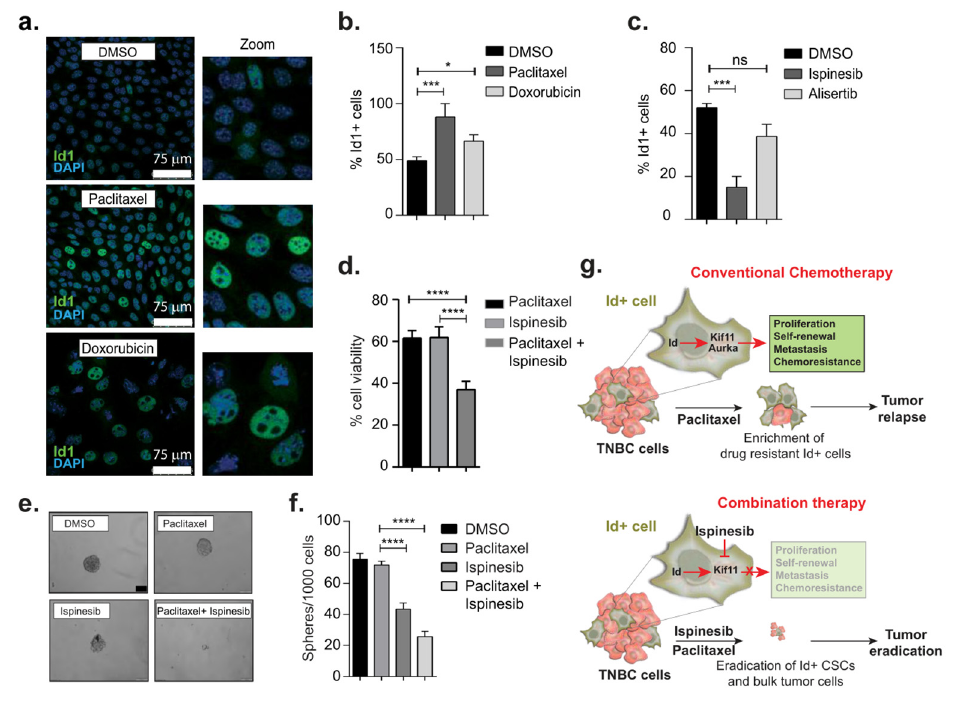
Figure 5. Therapeutic targeting of cancer stem cells (CSCs) through the Id1-Kif11 / Aurka axis. ( a ) Immunofluorescence images of cells to determine Id1 expression after treatment with paclitaxel and doxorubicin (20 × ). ( b ) Percentage cells expressing Id1 in control, paclitaxel-, and doxorubicin-treated cells as well as ispinesib and alisertib ( c ) were determined by immunofluorescence. ( d ) Cell viability was determined after treating the cells with paclitaxel, ispinesib, and the combination therapy of paclitaxel + ispinesib. Representative phase contrast images of tumor spheres ( e ) and quantification of number of tumor spheres per 1000 cells ( f ) in control, paclitaxel, ispinesib, and paclitaxel + ispinesib. ( g ) Schematic showing the targeting of Id–Kif11 axis with conventional and combination therapy leading to more e ff ective eradication of the entire tumor. All experiments were performed in three biological replicates and data were expressed as mean ± standard deviation. Unpaired Student’s t -test and two-way ANOVA were used. * p < 0.05, *** p < 0.001, **** p < 0.0001, ns is non